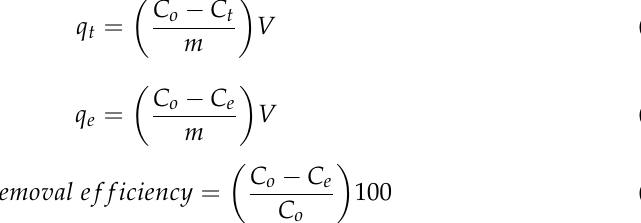
Figure 2. General representation of the CaSF structure.